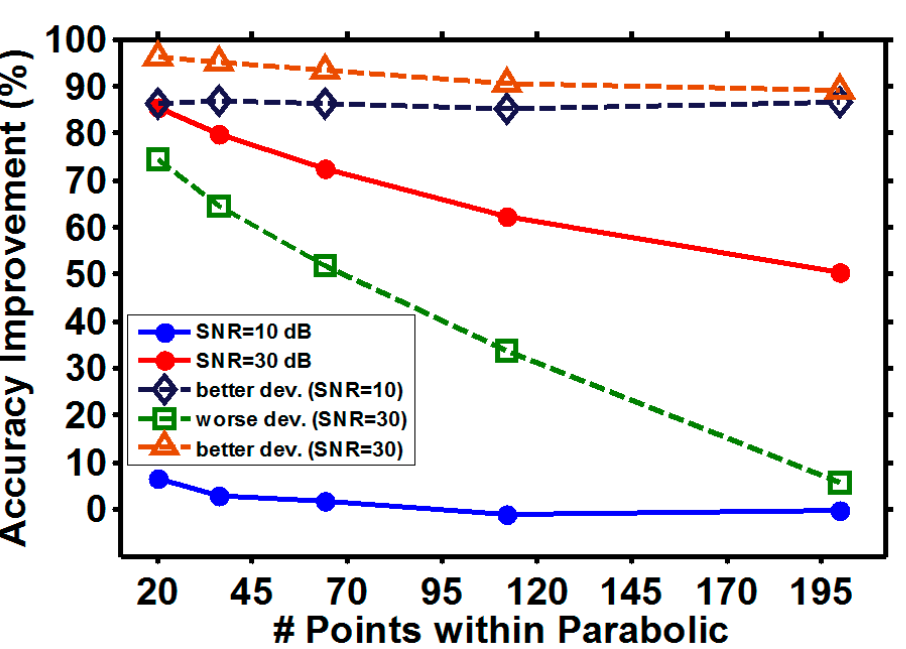
Figure 7. Accuracy improvement under different SNR conditions. Dash line: the potential variation induced from performance fluctuation of different schemes.